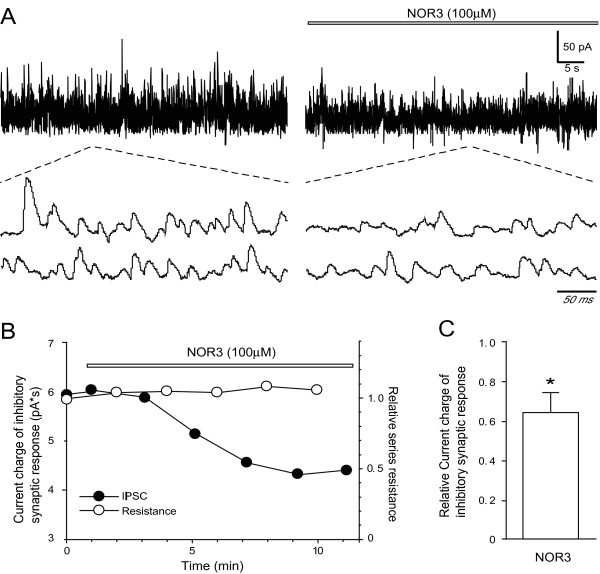
Representative action of NOR3 on inhibitory synaptic transmission in the SG of the spinal dorsal horn in vivo. A. Spontaneous IPSCs before and 8 min after (left trace) application of NOR3. Two lower consecutive traces of spontaneous IPSCs as shown in an expanded scale in time. B. Time course of the current charge amplitude of spontaneous IPSCs and relative series resistance of the recording under the action of NOR3. Data in A and B were obtained from the same neuron. C. Summary showing inhibitory action of NOR3 on inhibitory synaptic response. *P < 0.05 vs. control.